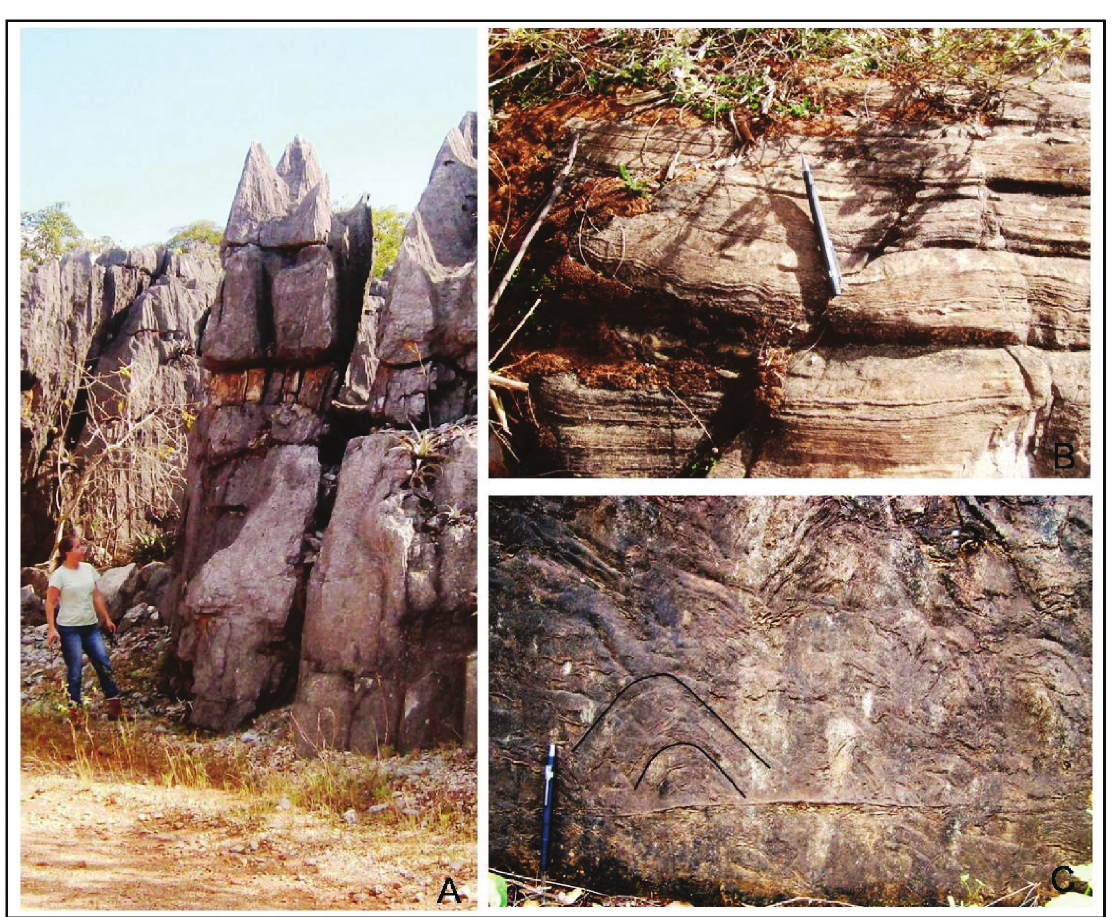
Figure 8 - Outcrop of gray dolostone along the railway near Conselheiro Mata district (A) , with stratiform stromatolite structures (B) , and (C) with hemispherical columnar